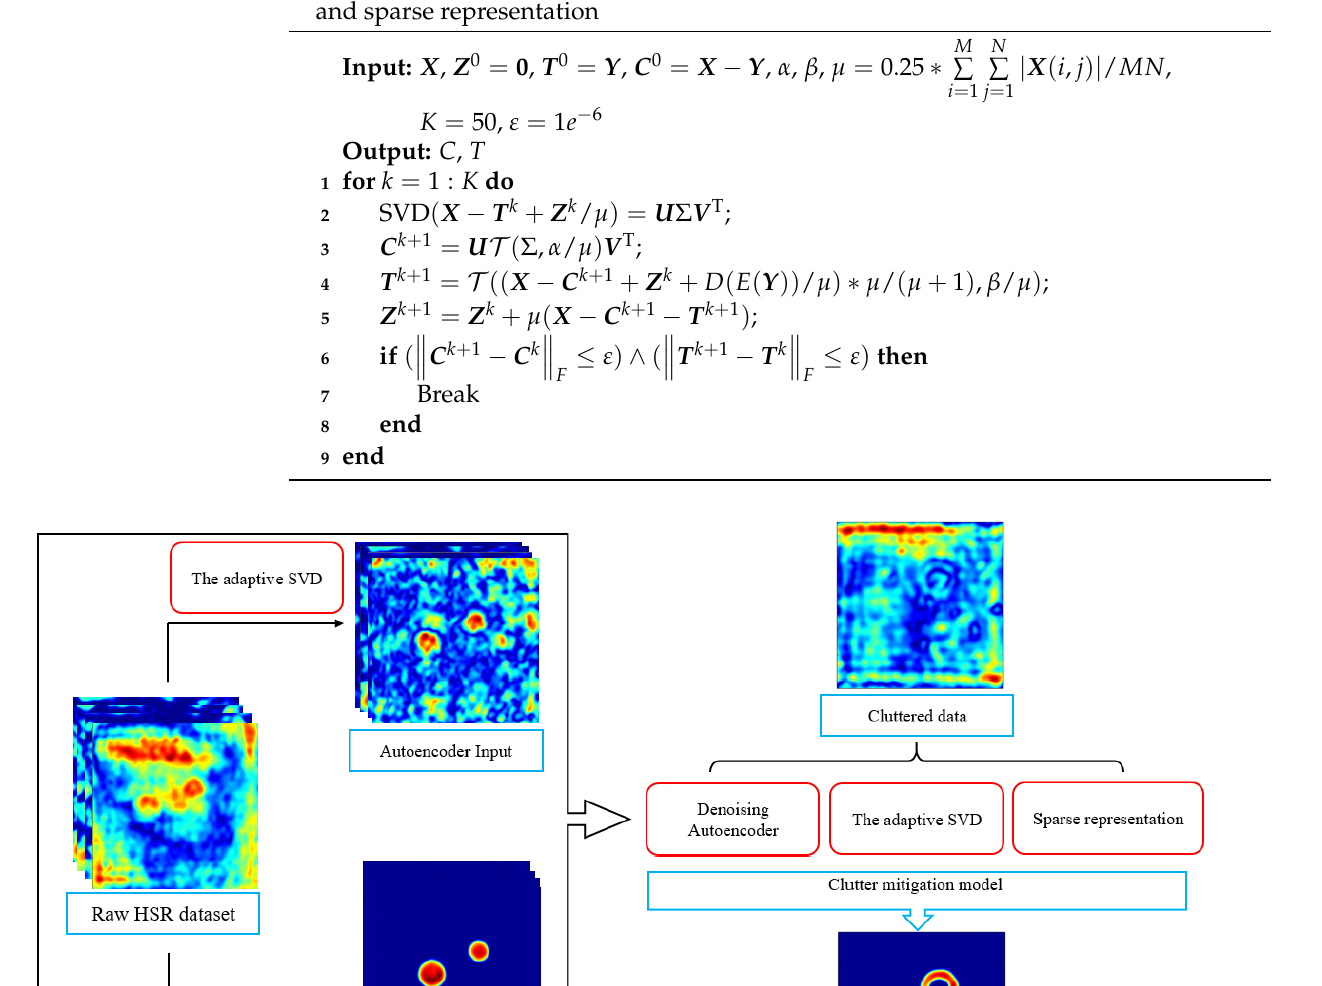
Algorithm 1: The ADMM for the learning-based model with subspace projection and sparse representation